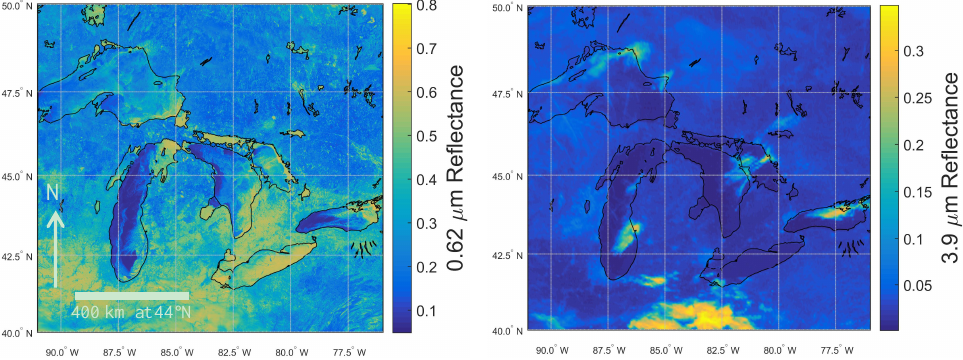
Figure 3. ( Left ) 28 February 2015 0.62 µm reflectance at 1830 UTC; ( right ) 3.9 µm reflective component.